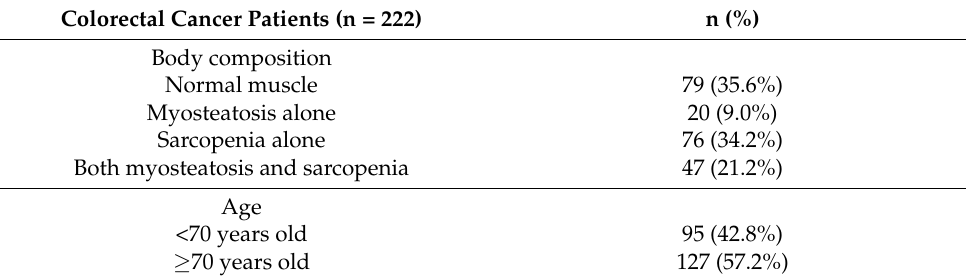
Table 1. Characteristics of colorectal cancer